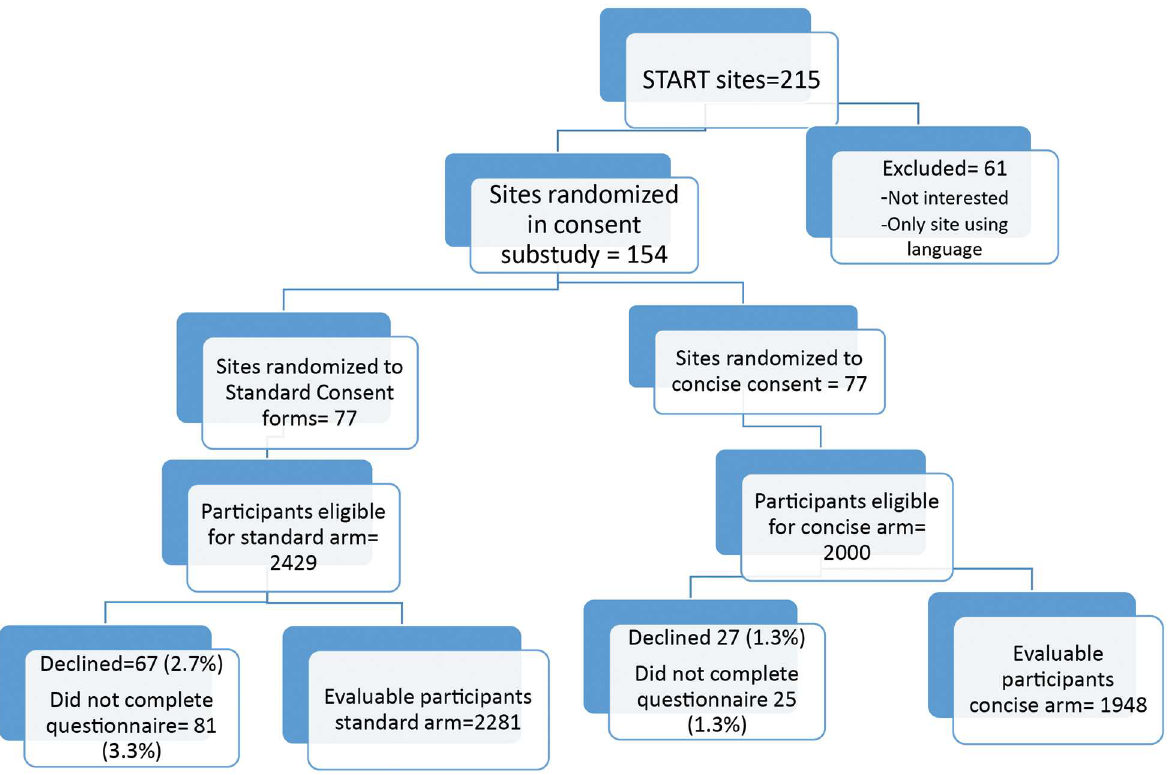
Fig 1. START informed consent substudy